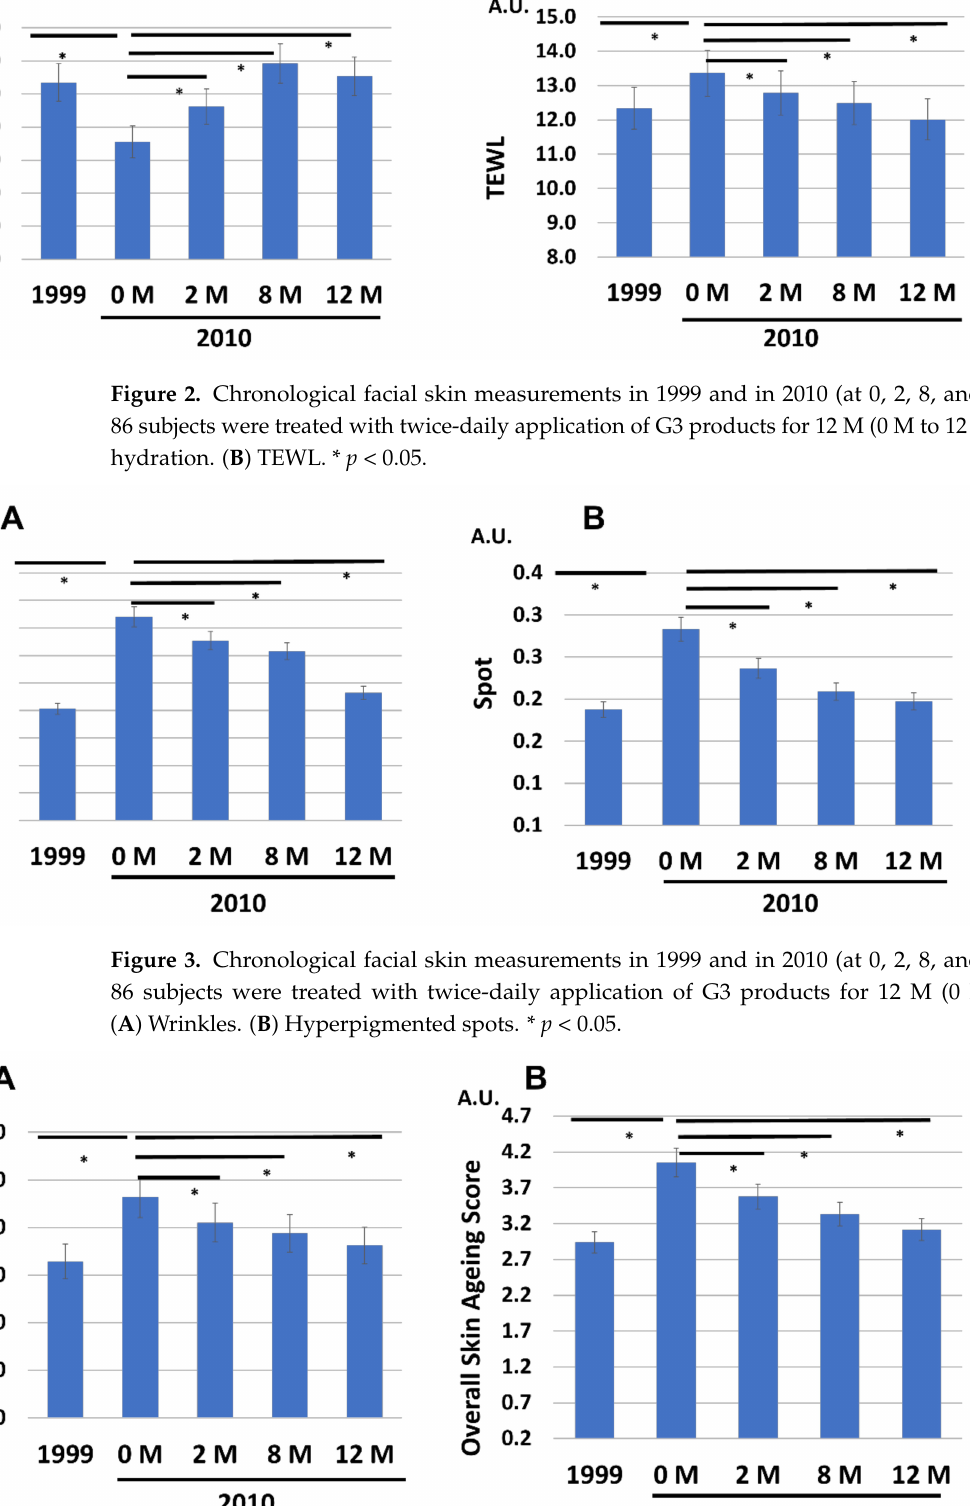
Figure 4. Chronological facial skin measurements in 1999 and in 2010 (at 0, 2, 8, and 12 M). All 86 subjects were treated with twice-daily application of G3 products for 12 M (0 M to 12 M). ( A ) Roughness. ( B ) Overall Skin Aging Score. * p <